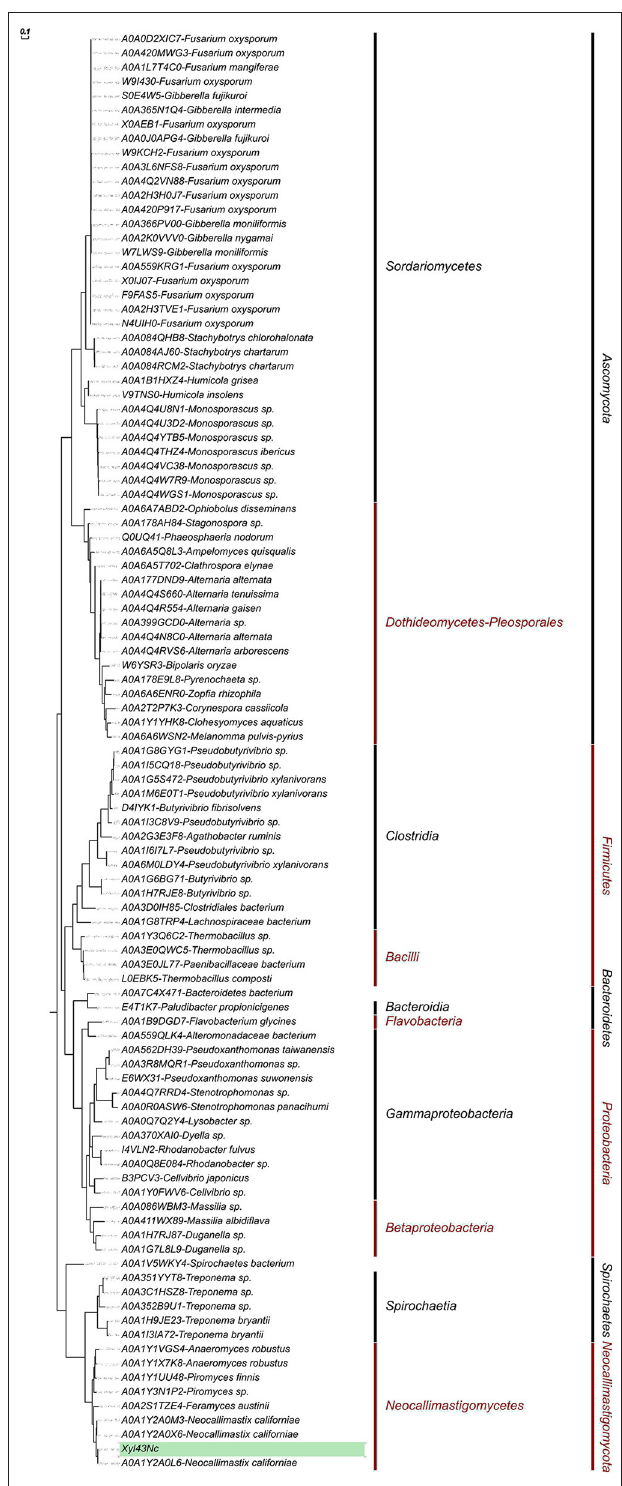
FIGURE 4 | Phylogenetic relationship of Xyl43Nc to other GH43_1 enzymes. Sequences were aligned using T-Coffee (Notredame et al., 2000). Phylogenies were reconstructed using IQ-TREE v2.0.3 (Minh et al., 2020) with the automatic model selection (WAG + I + G4) and –bb 1,000. The resulting tree was rooted using MAD (Tria et al.,